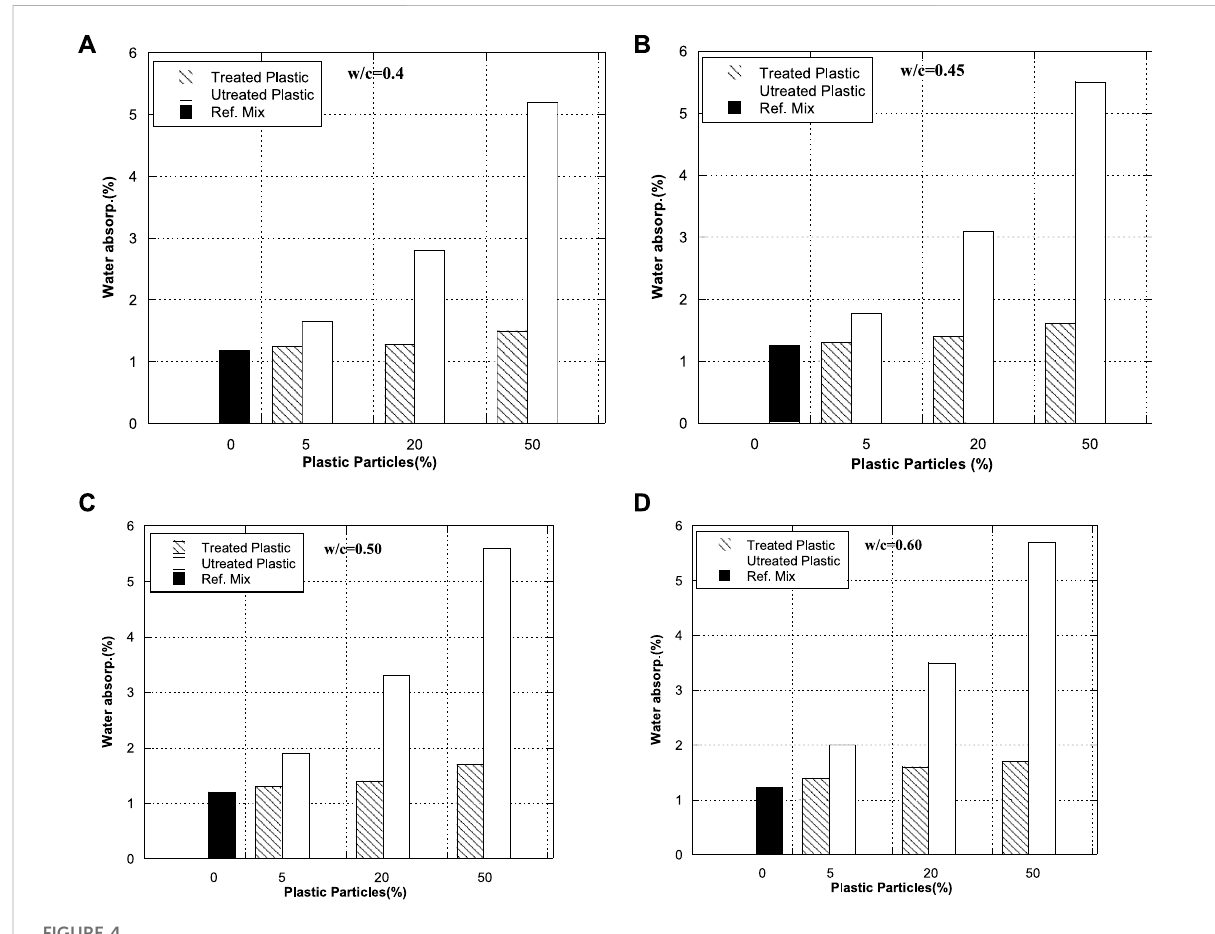
FIGURE 4 Water absorption % for different mixes (A) w/c = 0.40, (B) w/c = 0.45, (C) w/c = 0.50, and (D) w/c =